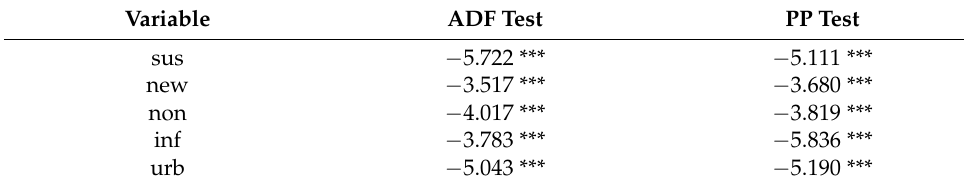
Table 2. Results of unit root test.